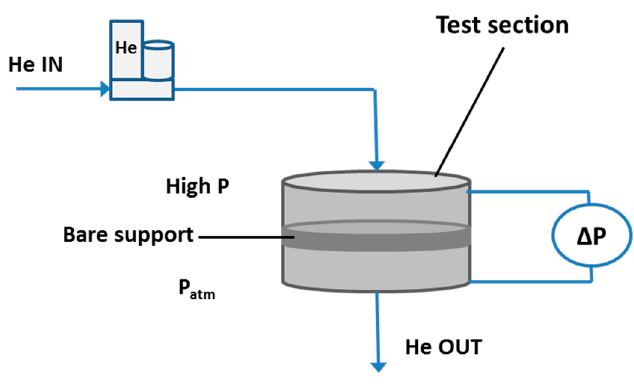
Figure 4. Experimental setup for test on bare support at room temperature.